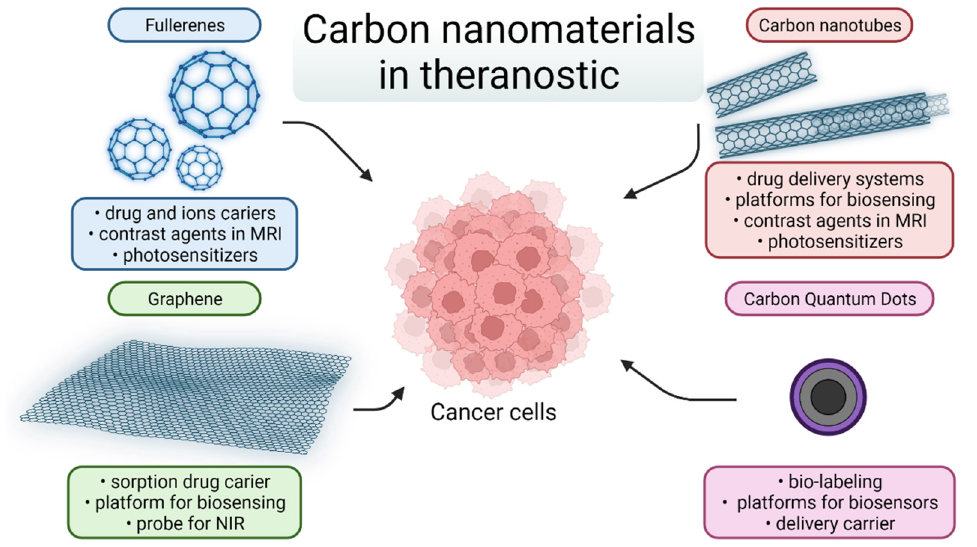
Figure 1. Examples of the use of carbon nanostructures in theranostics. The size scale is not propor- tional. The glow near the structures represents the functionalization and presence of different active substances. Created with BioRender.com.